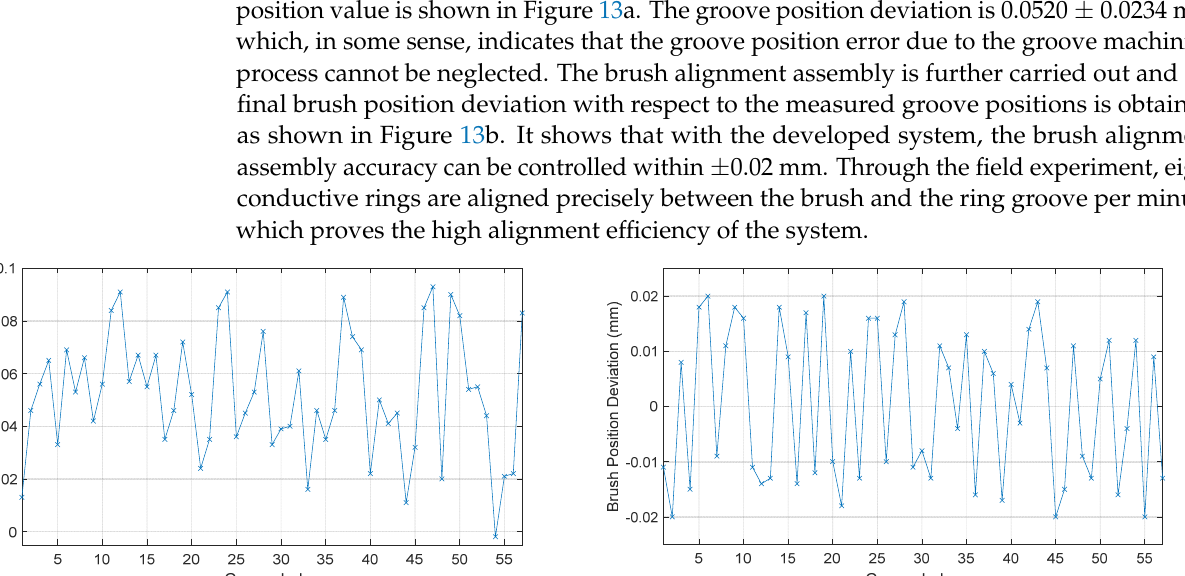
Figure 12. Calibration of optical imaging system.